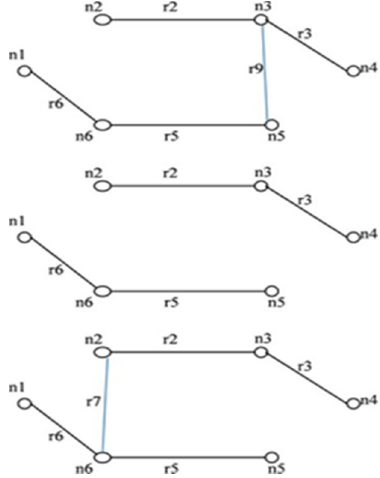
Figure 5. Illustration of rule 3 .